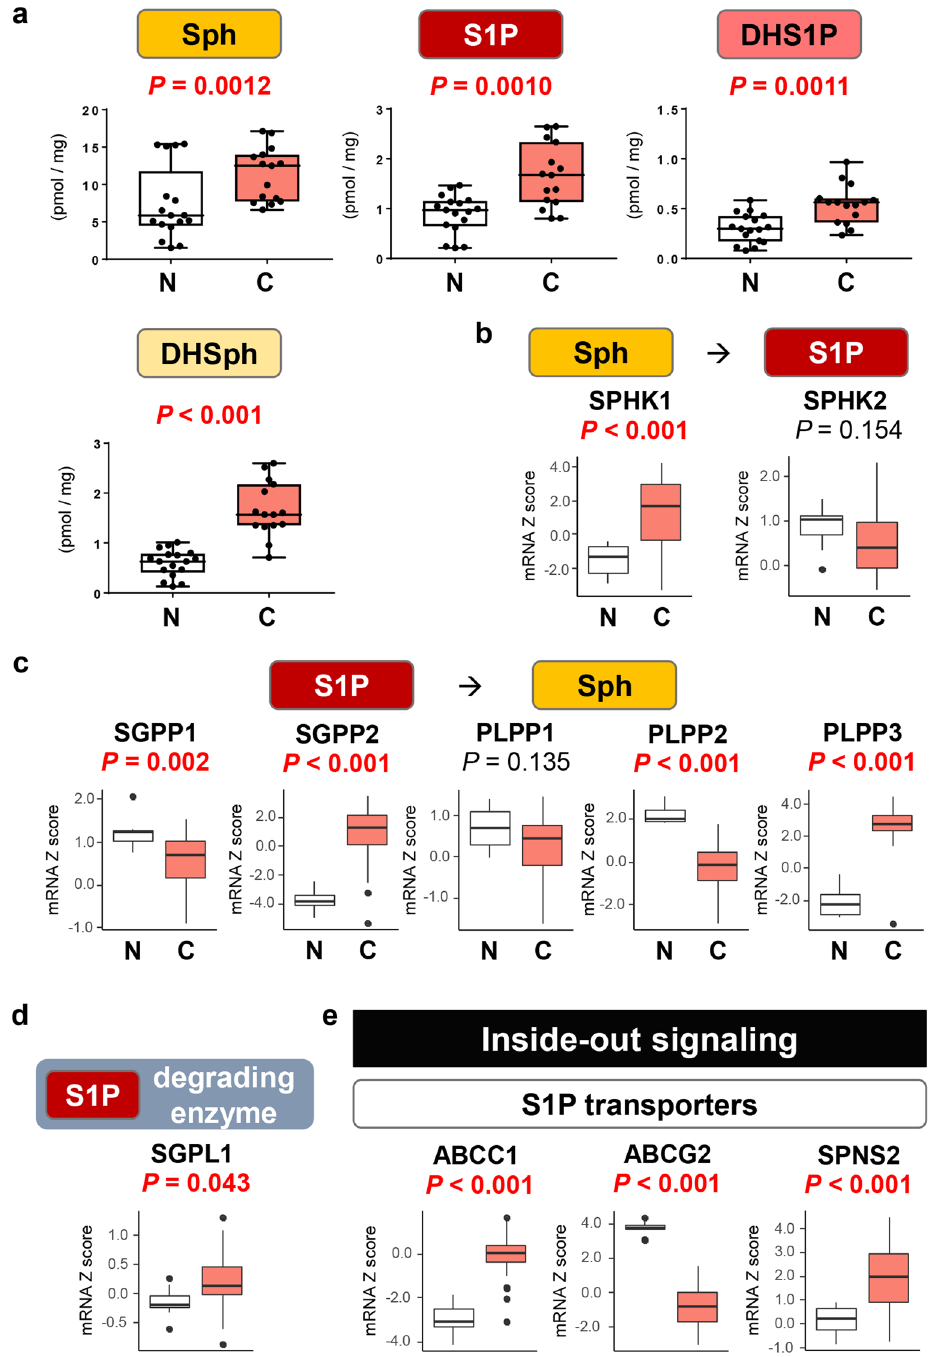
Figure 3. The levels of S1P and SPHK1 are increased in biliary tract cancer compared with normal biliary tract tissue. ( a ) The levels of the S1P, DHS1P, Sph and DHSph were determined by LC-ESI-MS/MS. ( b ) The gene expression levels of SPHK1 and SPHK2 in TCGA cohort (36 and 9 samples of cancer and non-cancer tissue in cholangiocarcinoma cohort) were analyzed. ( c ) The gene expression levels of SGPP1, SGPP2, PLPP1, PLPP2 and PLPP3 in the TCGA cohort were analyzed. ( d ) The gene expression level of SGPL1 in the TCGA cohort was analyzed. ( e ) The gene expression levels of ABCC1, ABCG2 and SPNS2 in the TCGA cohort were analyzed. Mean values are shown by the horizontal lines. Two-sided P values < 0.05 were considered statistically significant (Mann-Whitney U test). N: normal biliary tract tissue; C: biliary tract cancer